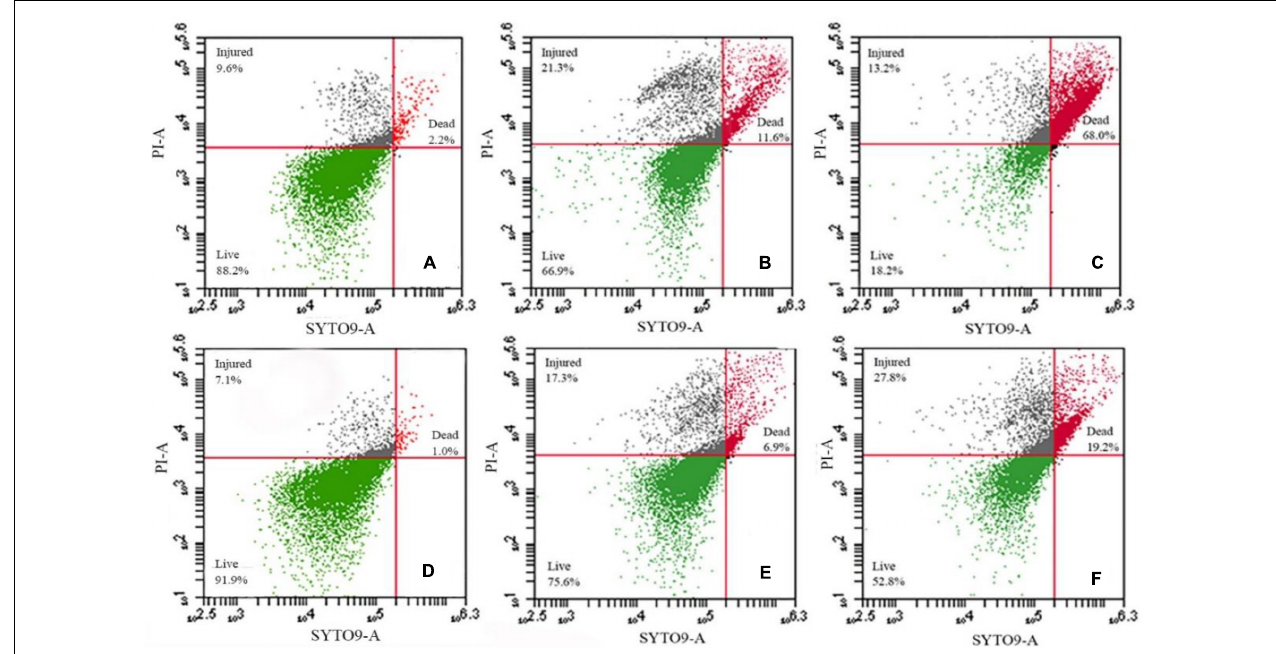
FIGURE 3 | S. Enteritidis CVCC 1806 (A–C) and S. Enteritidis S2002-13 (D–F) stained with SYTO9 plus PI after treatment with 100 mg/L NaClO for 0, 10 and 30 min.